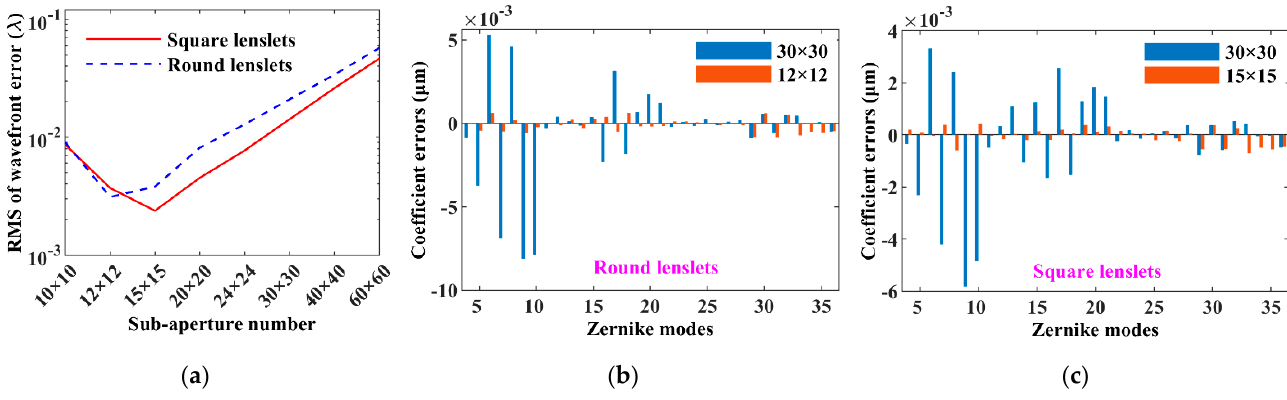
Figure 4. Effect of sub-aperture number on the performance of vSHWS. ( a ) RMS varying with sub-aperture number; comparisons of Zernike coefficient errors at non-optimized and optimized sub-aperture numbers when using ( b ) round and ( c ) square lenslets, respectively.